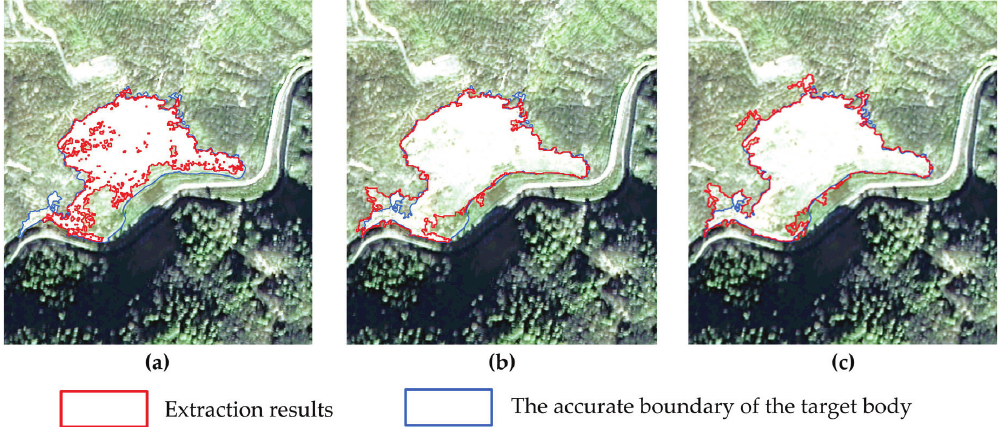
Figure 7. Comparison of extracted unstable slope using the three methods: (a) MLC; (b) OOC, and (c) Luv-RMWS.